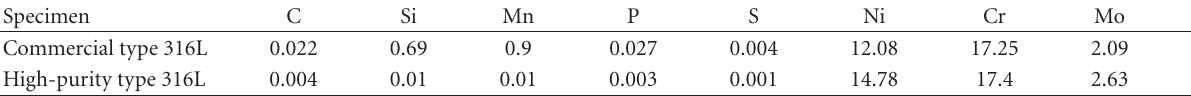
Table 1: Chemical composition of specimens (wt%).